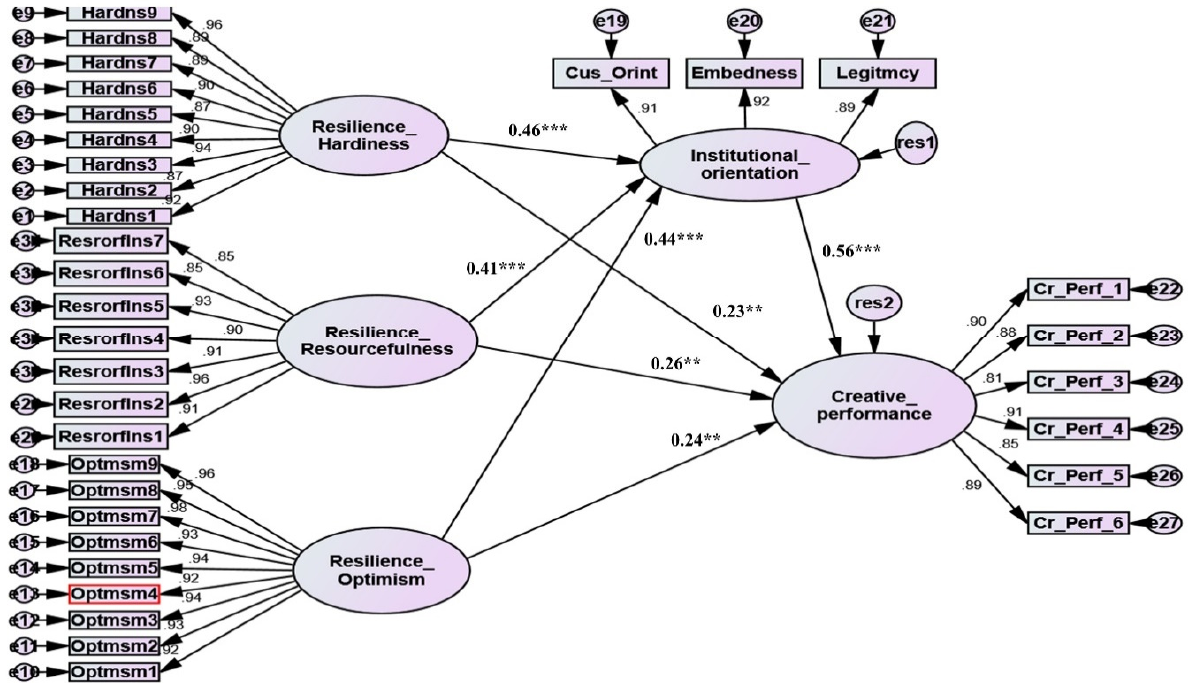
Figure 3. The results of the structural model from the Amos output. Source : Developed by authors. *** : significant level is below 0.001; ** significant level is below 0.01.